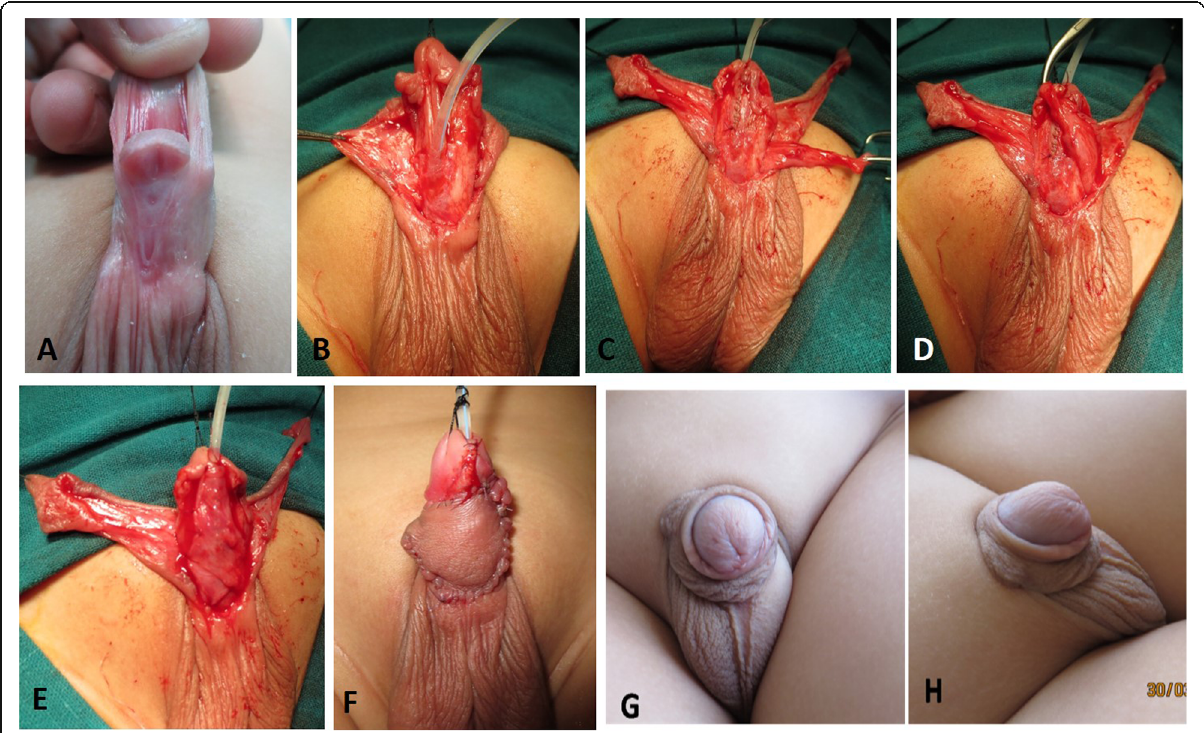
Fig. 1 30-month-old boy with proximal hypospadias from the hormonally treated group (group A). a Preoperative appearance after hormonal stimulation. b Intraoperative view for the urethral opening after complete degloving. c , d , and e A dartos flap is prepared as a second layer from half of the dorsal prepuce to cover the urethroplasty. f The other half of the dorsal prepuce is used to reconstruct the deficient ventral penile skin. g and h Follow up 6 months after surgical